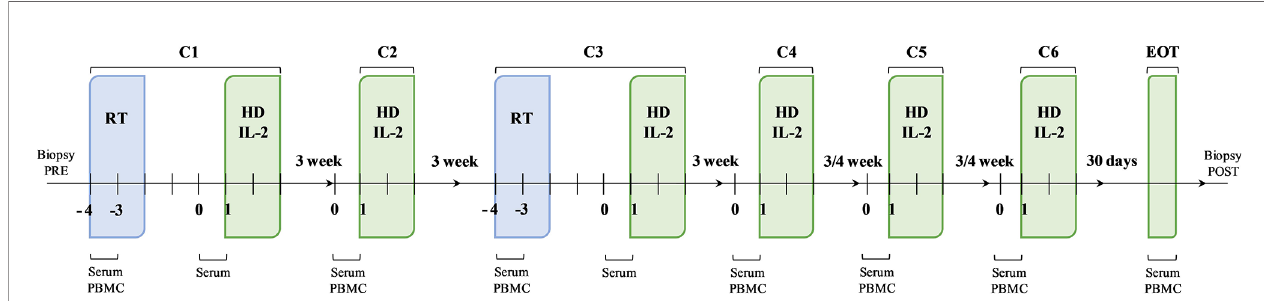
FIGURE 1 | Schematic representation of the therapeutic schedule and biological sample collection. The therapeutic strategy was based on a sequence of therapeutic cycles performed every 3 weeks up to cycle 4 (C4) and every 4 weeks thereafter for a further 2 cycles, up to a maximum of 6 months of treatment. At the fi rst (C1) and third (C3) cycle, the administration of high-dose interleukin-2 (HD IL-2) was preceded by radiotherapy. The second (C2), the fourth (C4), the fi fth (C5) and the sixth (C6) cycles consisted in the administration of HD IL-2 only. Biological samples were collected at established times during